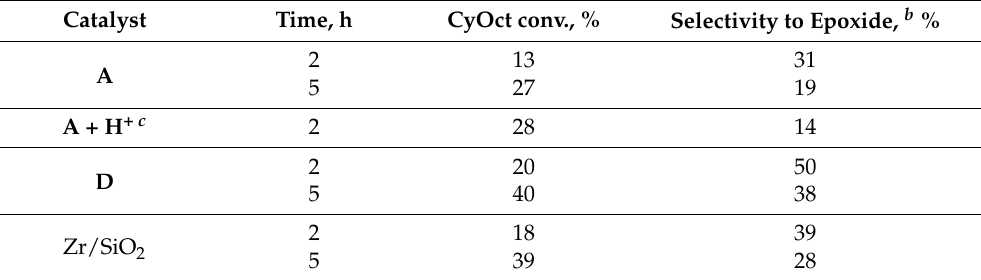
Table 3. Cyclooctene oxidation with H 2 O 2 in the presence of Zr-Si catalysts a . Catalyst Time, h CyOct conv., %